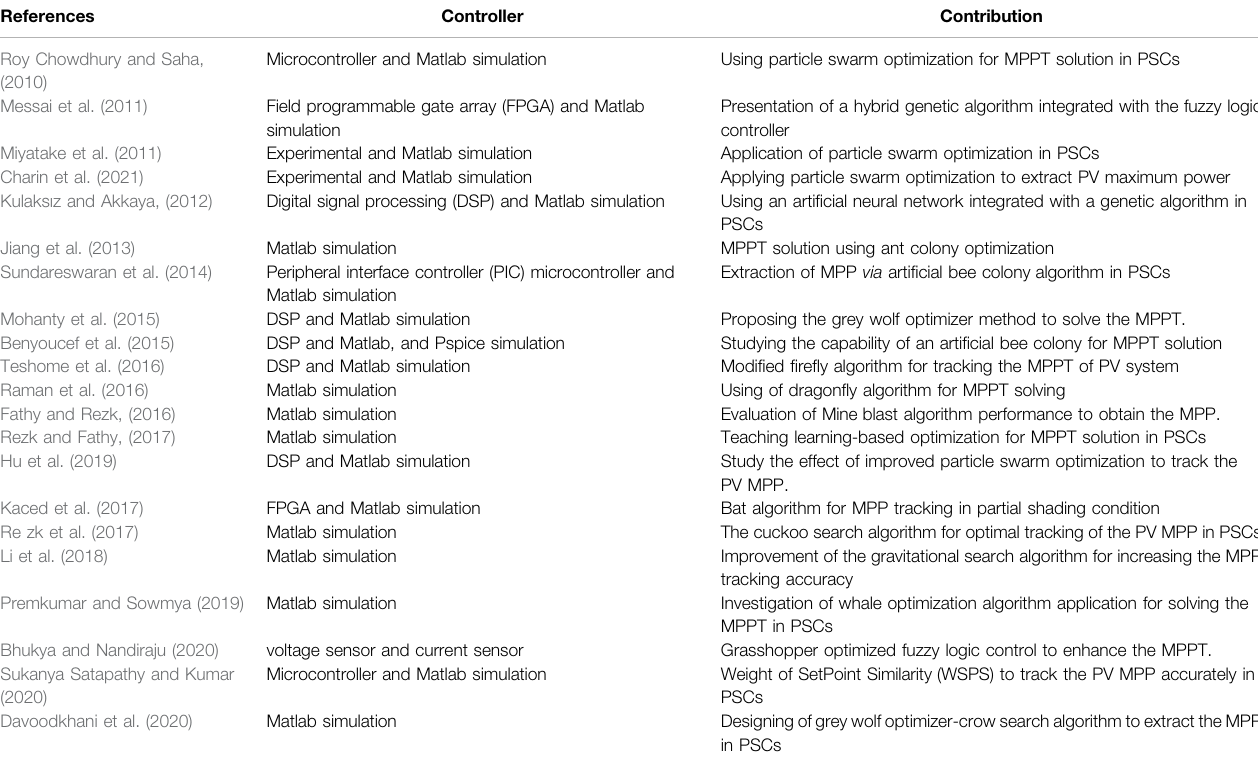
TABLE 1 | State of the art of MPPT